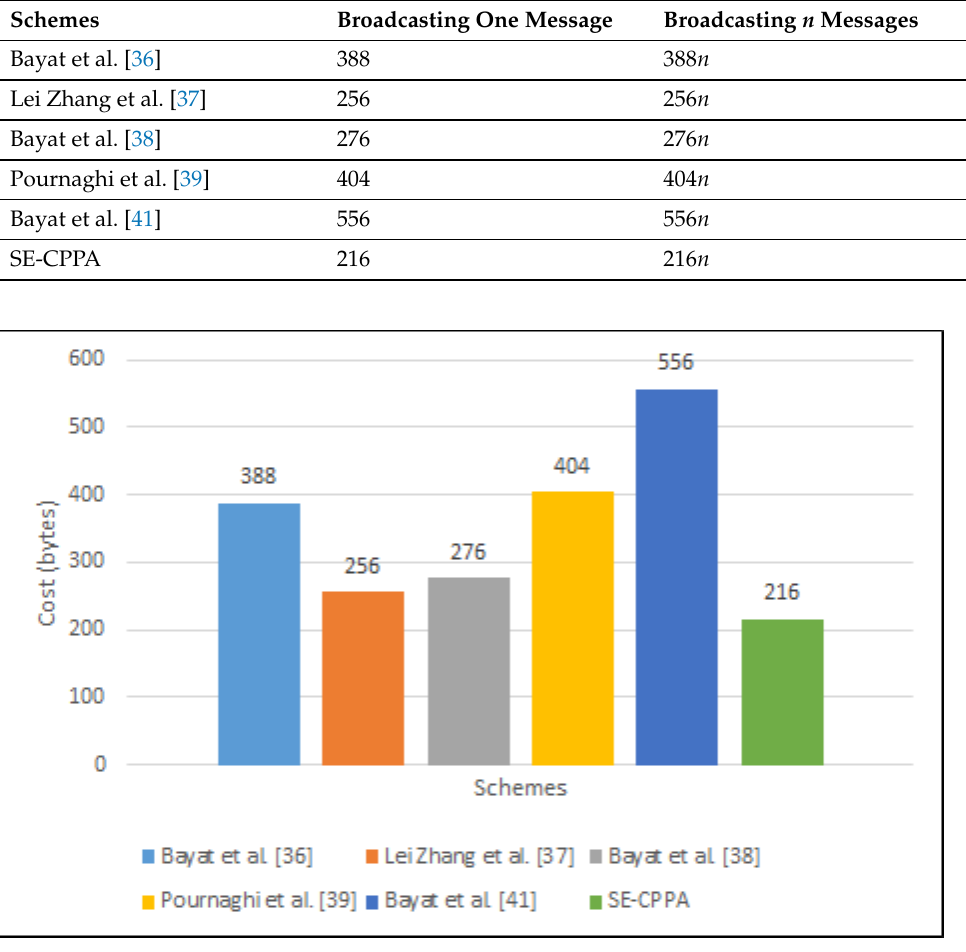
Figure 8. Communication overhead comparison based on bilinear